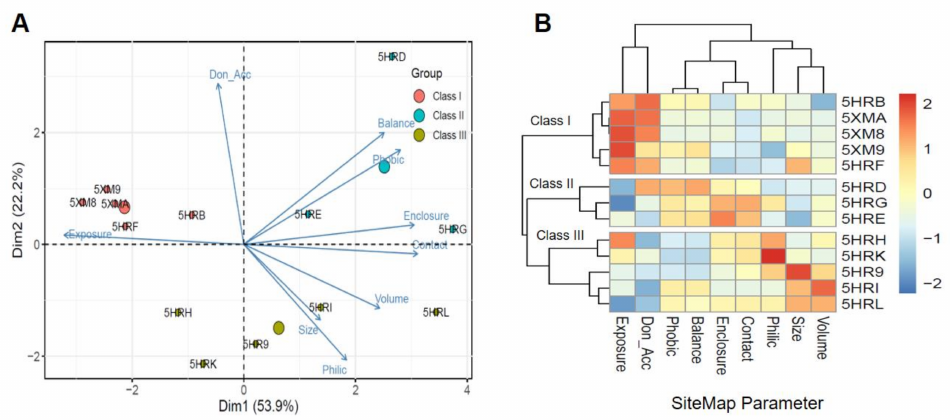
Figure 1. PCA plot and heatmap of selected binding sites on the Asfv PolX protein. ( A ) PCA of selected potential binding sites on Asfv PolX protein structures. The loading plot vectors are represented by arrows for each SiteMap parameter. The red, blue, and green dots represent Class I, Class II, and Class III, respectively. ( B ) The heatmap clustering of the SiteMap parameters of the selected binding sites on Asfv PolX protein. Blue color represents low and red color represents high score levels. Both the heatmap and PCA were constructed using R software version 4.0.1 (6 June